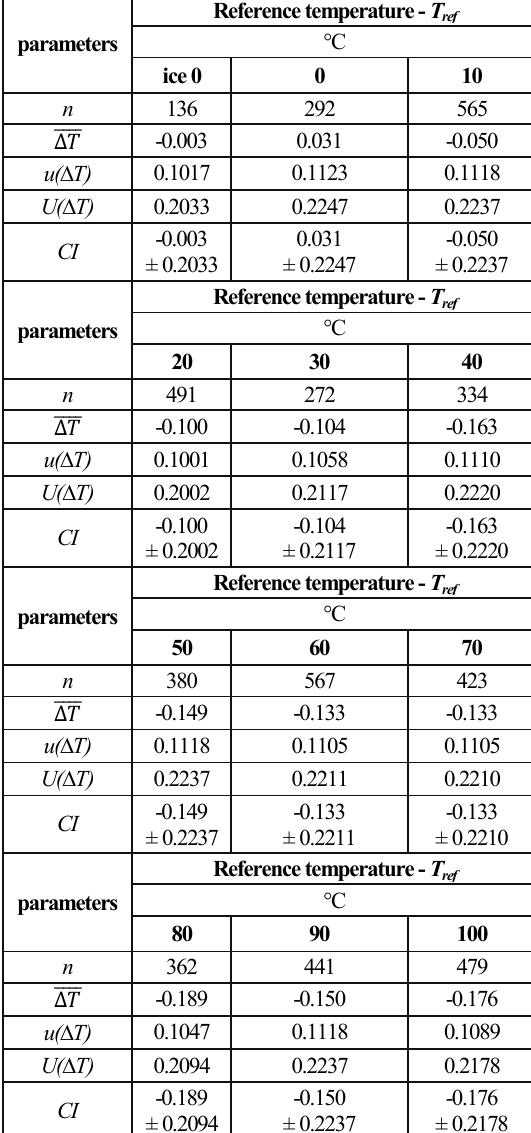
Table 3. Selected basic parameters for the difference in temperature measurement.